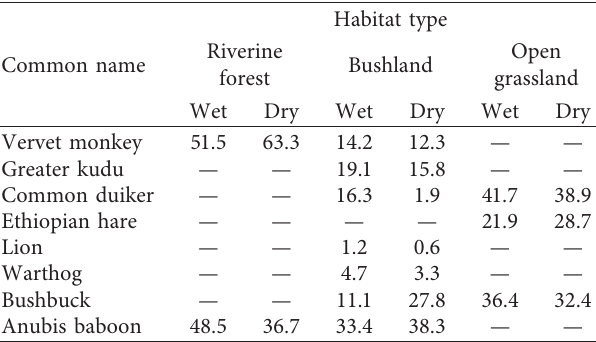
Table 3: Relative abundance of mammalian species in the three habitat types.